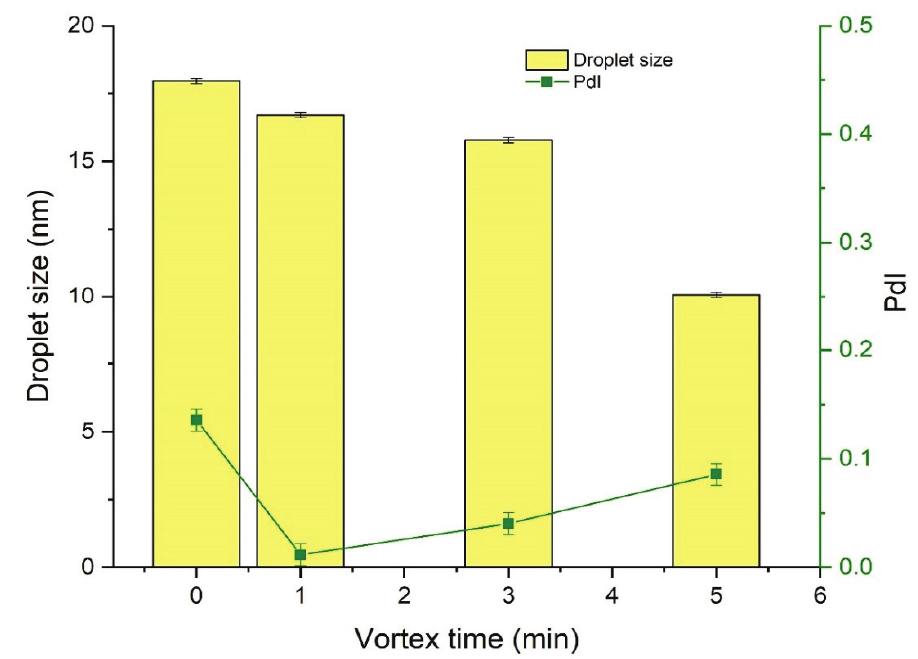
Figure 2. Effect of vortex time on the droplet size and polydispersity index (PdI) of nanoemulsion preparations. The increase in vortexing duration provided more energy to further minimize the droplet size of developing nanoemulsion system. Different compositions of RT-loaded NEs, with oil concentrations ranging from 10–20%, Smix concentrations (2:1) ranging from 45–50%, and water concentrations ranging from 30–45% were prepared and characterized in terms of thermodynamic stability, percentage transmittance (%T), viscosity, drug content, droplet size, PdI, and zeta potential (Table